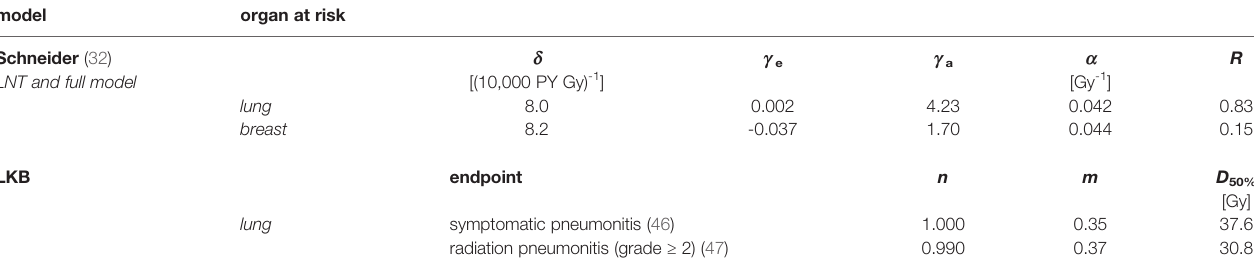
TABLE 2 | EAR and NTCP calculation